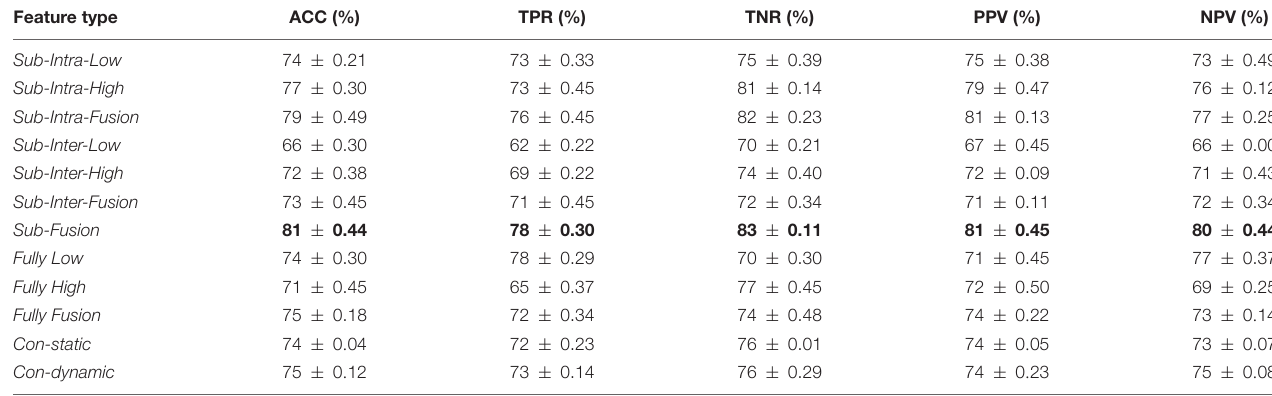
TABLE 2 | ASD classification performance using different